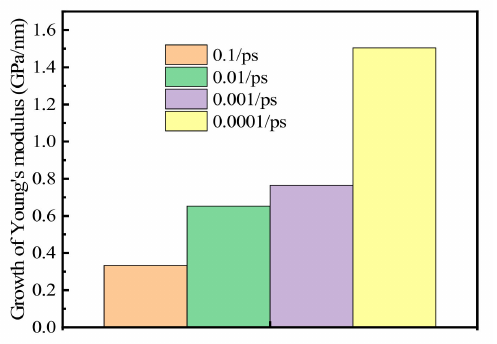
Figure 6. Growth rates of Young’s modulus with increasing grain size at varying strain rates.